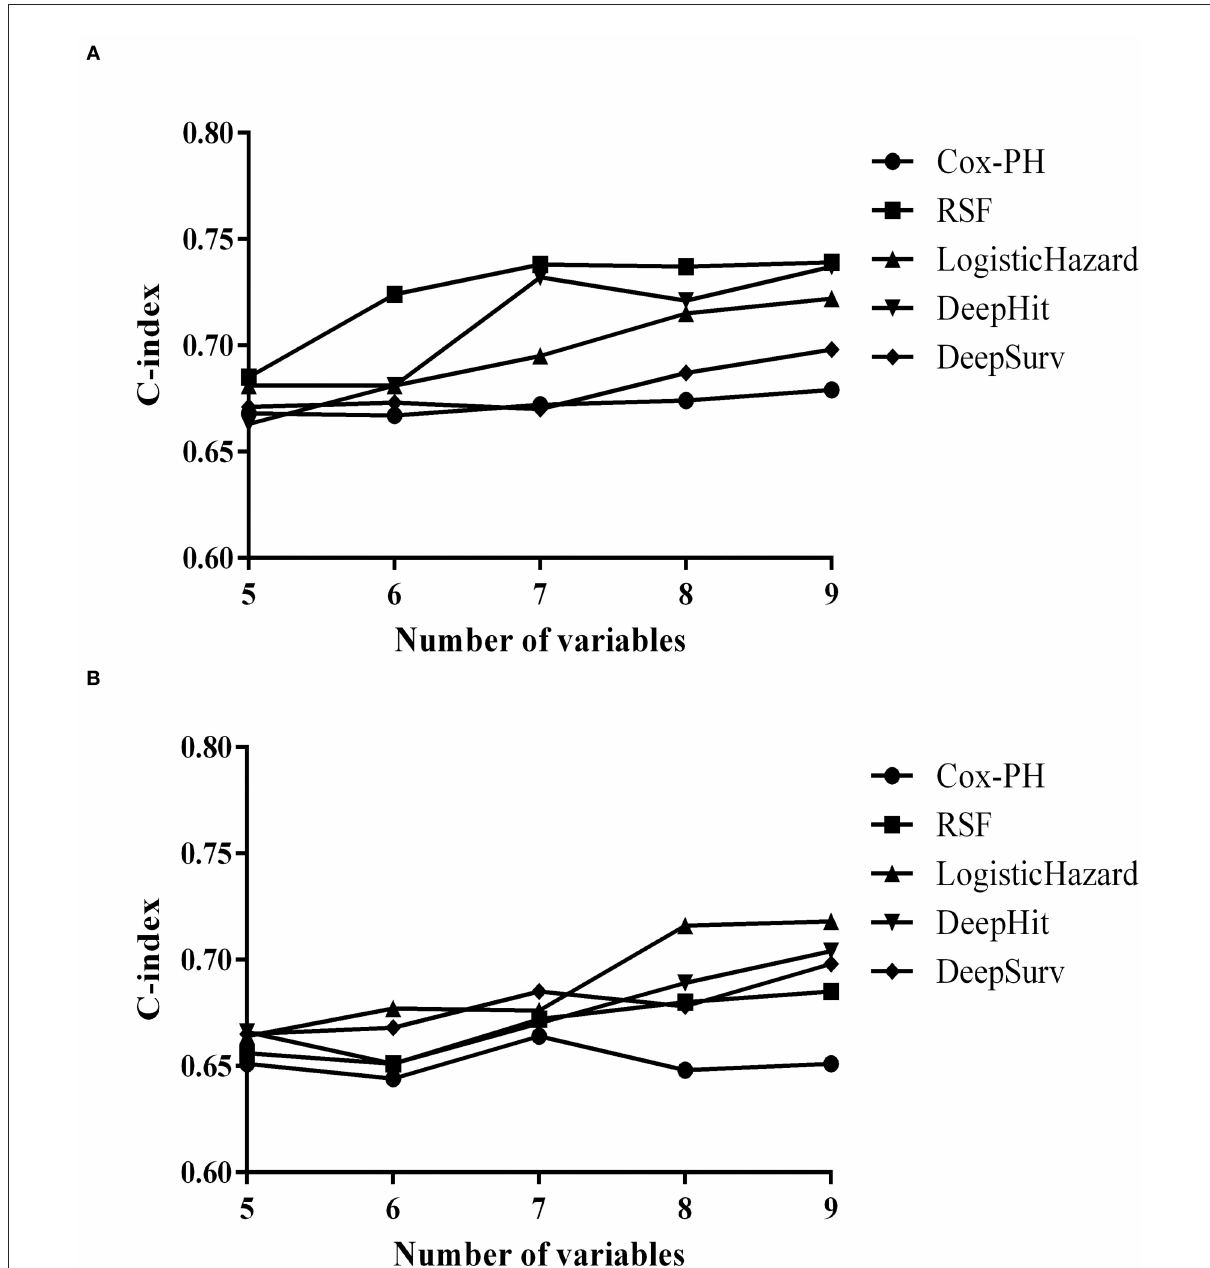
FIGURE2 Concordance indexes (C-indexes) in different prediction models with added variables. (A) Of the training set. (B) Of the validation set.